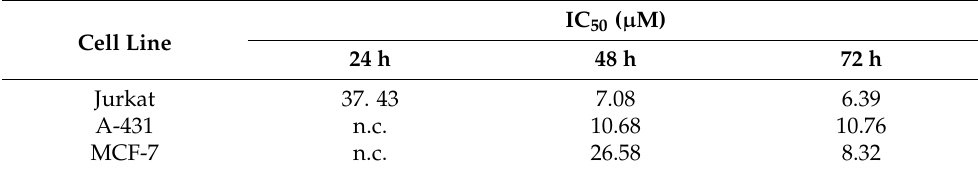
Table 1. IC 50 values calculated from dose–response curves of Jurkat, A-431, and MCF-7 cells treated with smenolactone D for 24, 48, or 72 h.